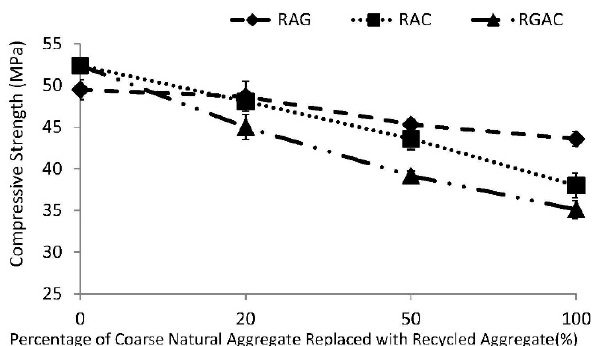
Figure 9: Percentage of Coarse NA Replaced with RCA (%)